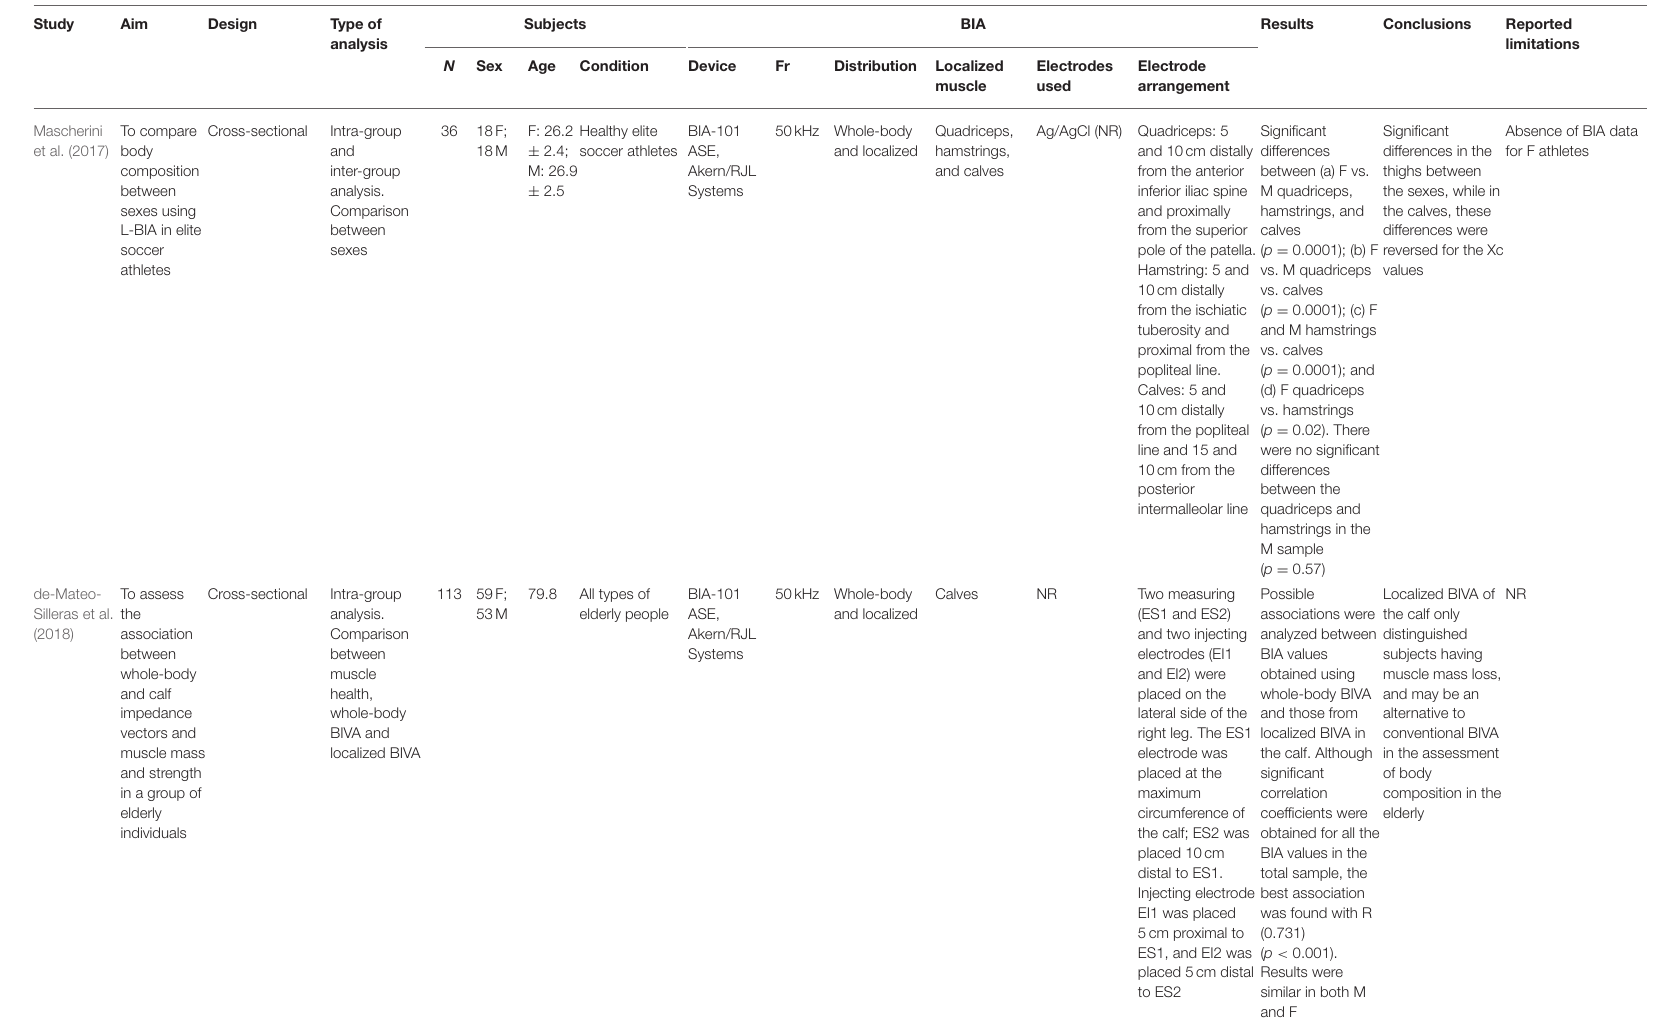
Ag/AgCl (NR) Quadriceps: 5